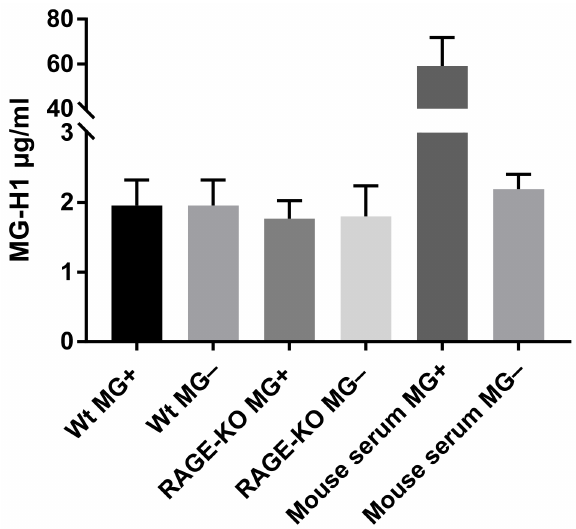
Figure 3. MG-derived AGEs formation in lung lysates after 12 months of feeding with MG or with tap water. Data are shown as mean SD ( n = 5 in each group). No significant differences within the four experimental groups were determined using one-way ANOVA. The positive control represents mouse serum incubated for 5 days at 37 ◦ C with 10 mM MG in comparison with the negative control, serum without addition of